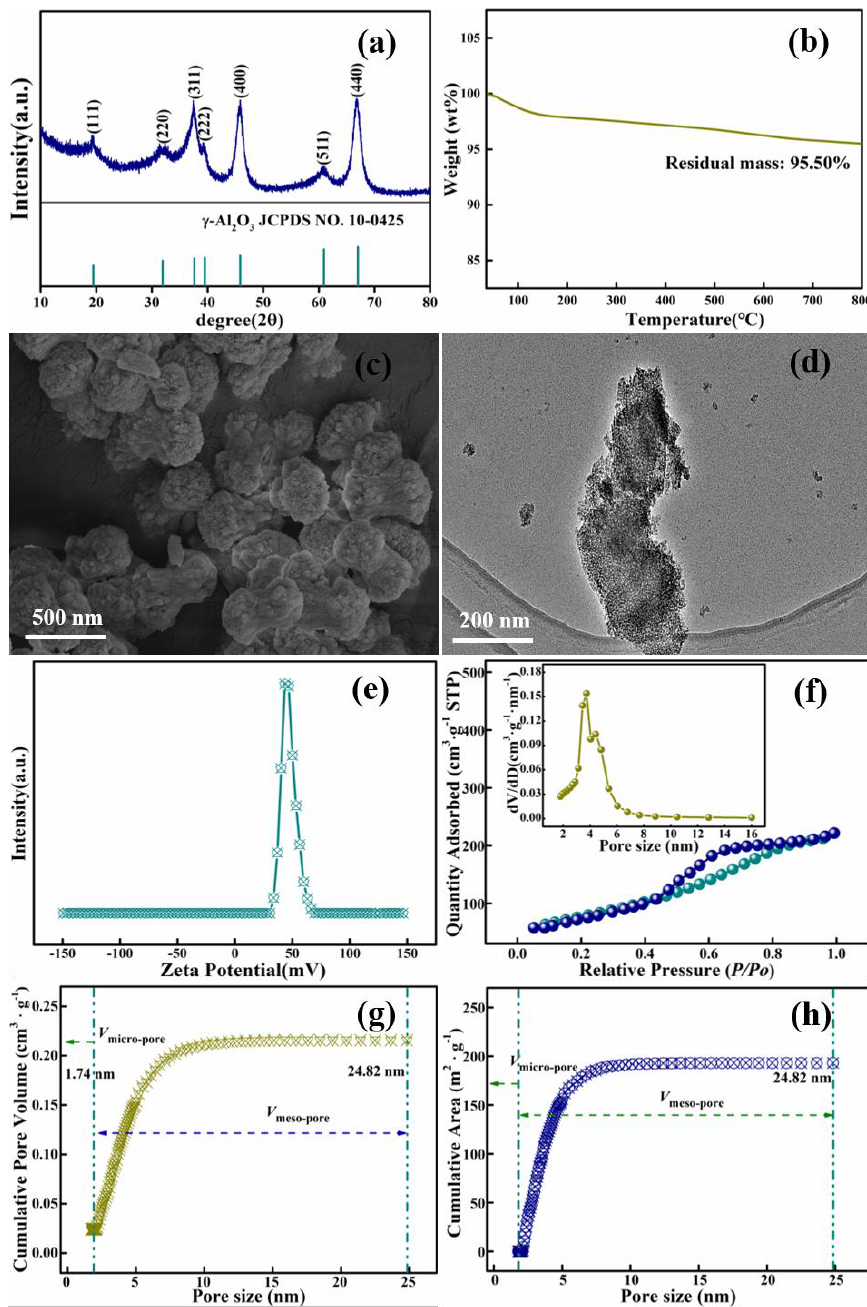
Figure 8. XRD pattern ( a ); TGA diagram ( b ); SEM image ( c ); TEM picture ( d ); Zeta potential plots ( e ); Nitrogen adsorption–desorption isotherms ( f ); cumulative pore volume ( g ); and cumulative